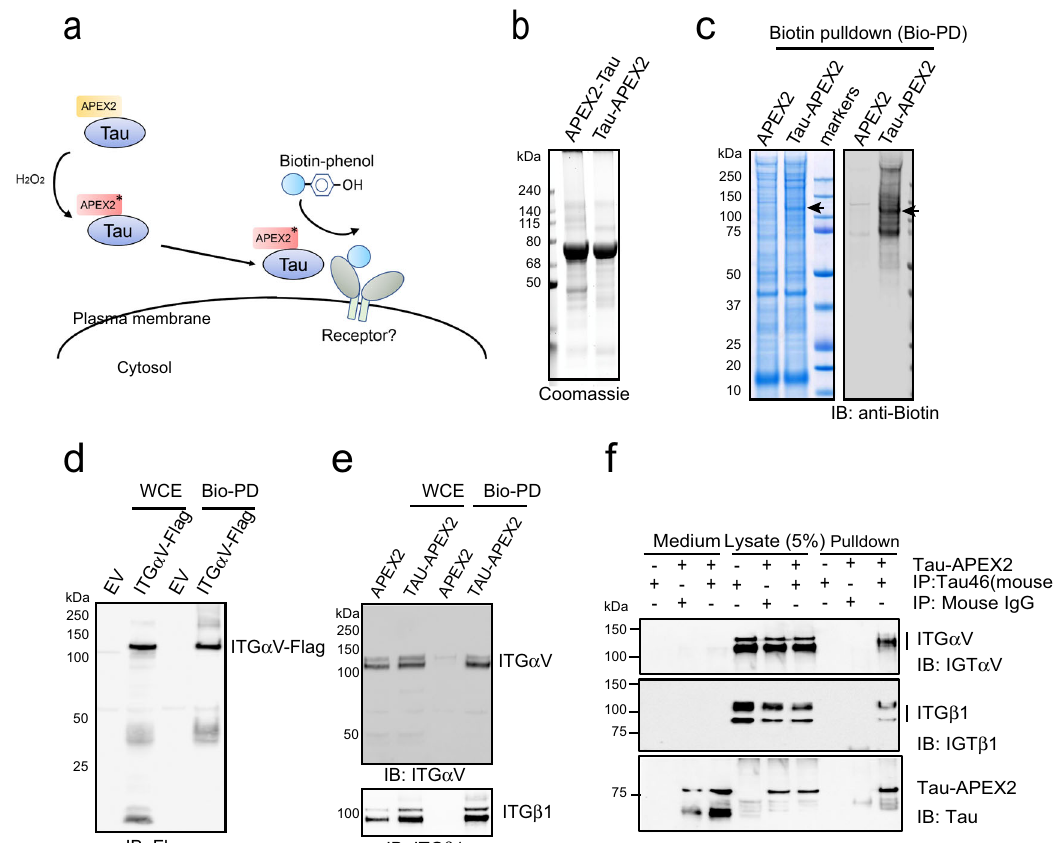
Fig. 1 Identi fi cation of integrin α V/ β 1 as a Tau interactor in primary astrocytes. a Schematic overview of the proximity-based proteomic mapping strategy. Tau-APEX2 (200 nM) is bound to the cell surface. Biotinylation was initiated by incubating cells with biotin-phenol (BP) in the presence of H 2 O 2 for 4 min. Biotinylated proteins were then puri fi ed by af fi nity chromatography using streptavidin resin. b Coomassie blue staining of puri fi ed Tau proteins. c Coomassie blue staining (left) and immunoblotting (IB) (right) of biotinylated proteins from primary astrocytes incubated with APEX2 or Tau-APEX2. The arrow indicates a 120 kDa protein detected in Tau-APEX2-treated cells. d , e Validation of Tau-APEX2-mediated biotinylation of ITG α V/ β 1. d Tau- APEX2 was incubated with HEK293T cells transfected with either an empty vector (EV) or ITG α V-Flag. Whole cell extracts (WCE) were either directly analyzed by immunoblotting or fi rst subjected to biotin pulldown (Bio-PD) before immunoblotting. e Whole cell extracts (WCE) from primary astrocytes treated with either APEX2 or Tau-APEX2 were analyzed directly by immunoblotting or fi rst subjected to biotin pulldown before immunoblotting. f Co-immunoprecipitation of Tau-APEX2 with ITG α V β 1. Astrocytes were treated with Tau-APEX2 (200 nM) or PBS as a control for 30 min on ice. Cells were lysed in an NP40-containing lysis buffer. Cell lysates were subjected to immunoprecipitation with either a control IgG or a Tau speci fi c antibody (Tau- 46). Both cell lysates and precipitated proteins were analyzed by immunoblotting. Where indicated, a fraction of the remaining medium was also analyzed by immunoblotting to show